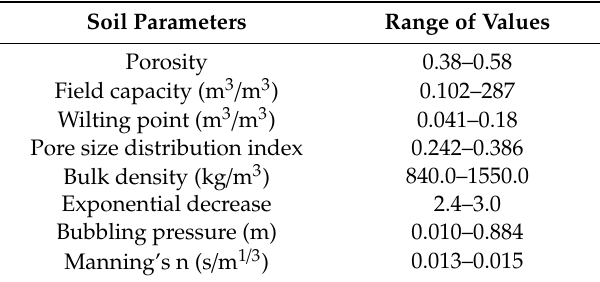
Table 2. Soil parameters used in DHSVM to calibrate the hydrologic models for di ff erent